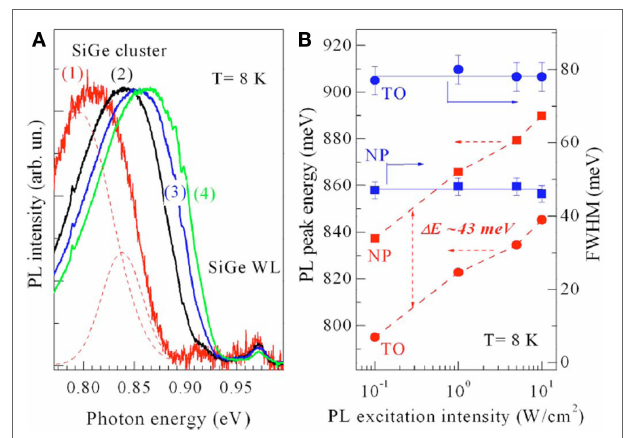
FiGURe 9 | (A) Normalized low-temperature PL spectra in CVD grown Si/ SiGe 3D nanostructures showing the PL spectral shift to higher photon energy under increasing CW excitation intensity [trace (1) 0.1, (2), 1, (3) 5, and (4) 10 W/cm 2 ] at 2.41 eV (514.5 nm). Each spectrum can be fitted with two Gaussian spectral bands [the transverse-optic (TO) phonon replica and no-phonon (NP) lines, respectively], as shown, for example, by the dashed lines under trace (1). (B) The NP and TO line positions and widths [full-width at half maximum (FWHM)] as a function of excitation intensity (Lockwood and Tsybeskov,